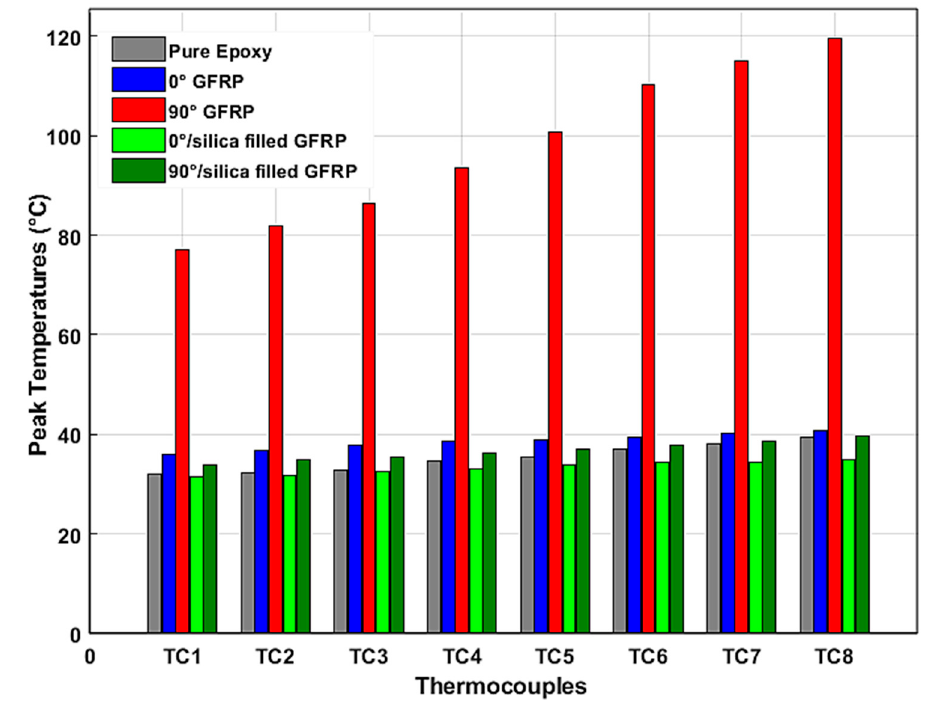
Figure 4. Peak temperatures measurements of each thermocouple (0.08 °C ≤ SD ≤ 2.86 °C). According to the temperature measurement evolution during processing illustrated